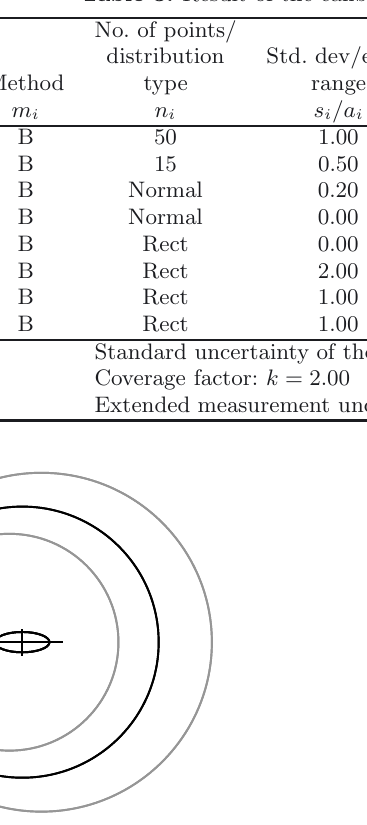
Fig. 4. Uncertainty of measured points that are not equally distributed around a circle.